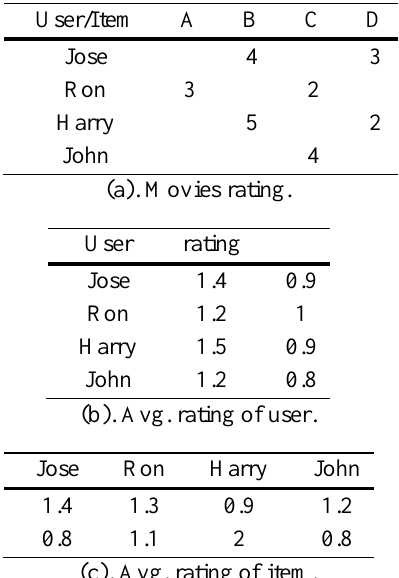
Table 3 . Matrix decomposition of users and